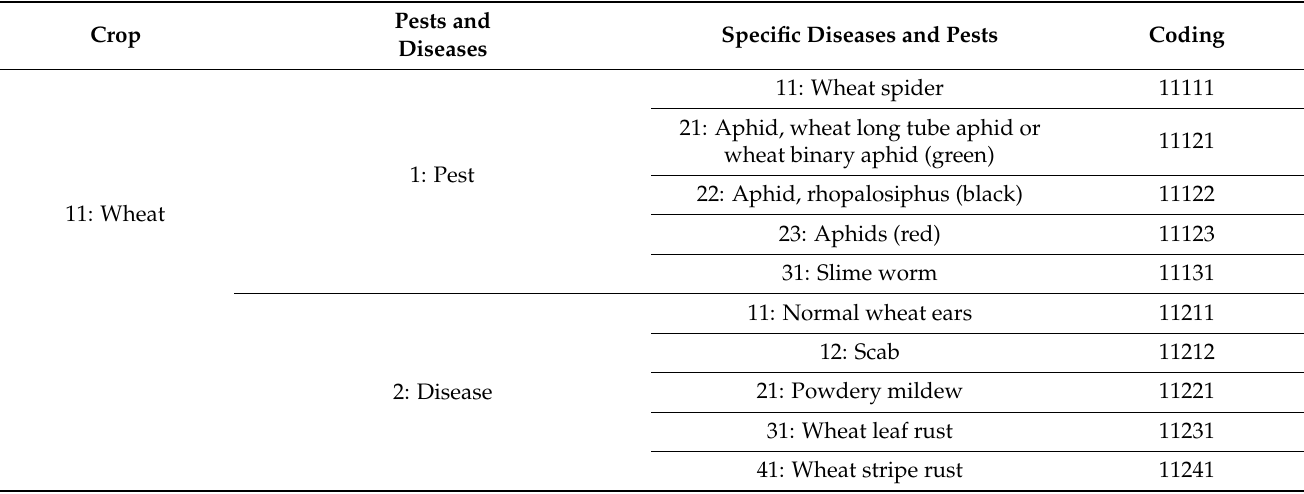
Table 1. Coding table of diseases and pests with different crops.